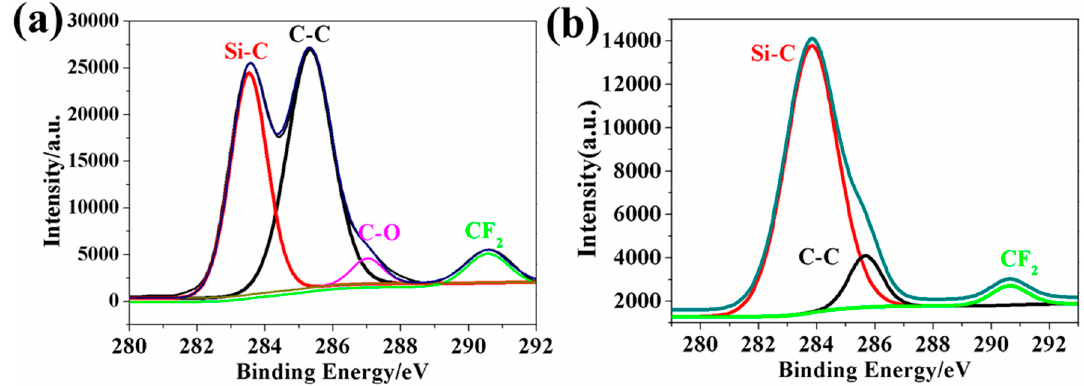
Figure 3. C 1s X-ray photoelectron spectroscopy (XPS) spectra of ( a ) sanded wood coated with KH1322 and 0.5% SiO 2 and ( b ) sanded wood coated with KH1322 and 2.0% SiO 2 .